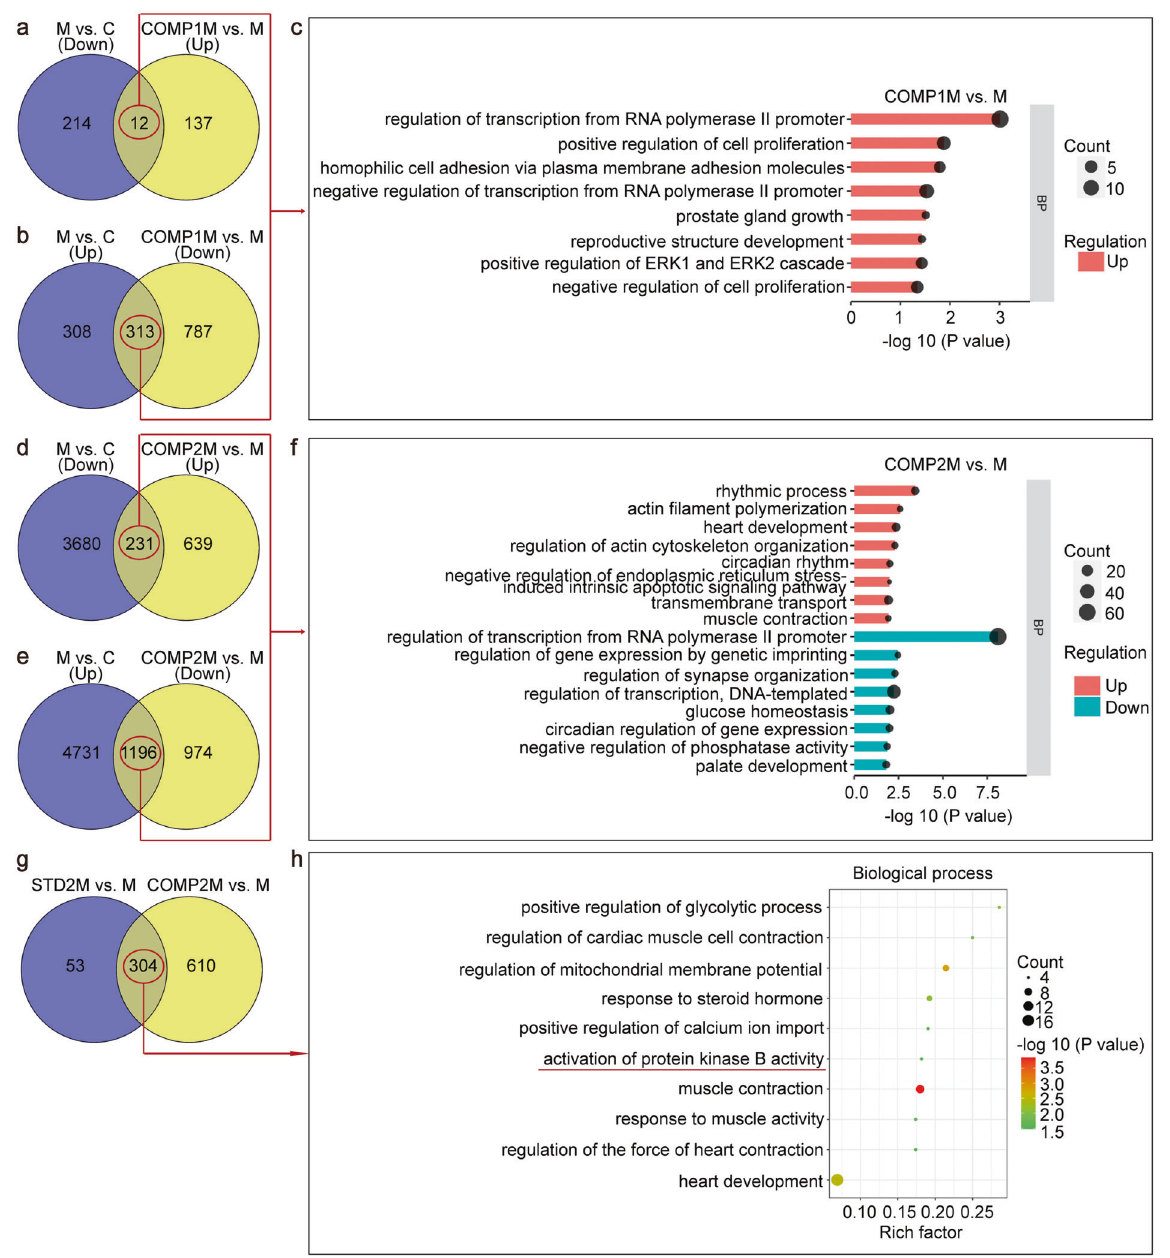
Fig. 6 Gene expression pro fi ling of the heart by RNA-seq after hiPS-CMs transplantation treatment. a Venn diagram showing that the upregulated differentially expressed genes (DEGs) of “ COMP1M vs. M ” group overlap with the downregulated DEGs of “ M vs. C ” group, for a total of 12 overlapping genes. b Venn diagram showing the intersection of upregulated DEGs in the “ M vs. C ” group and the downregulated DEGs in the “ COMP1M vs. M ” group, with a total of 313 intersecting genes. c Gene ontology (GO) enrichment analysis of the 12 and 313 DEGs obtained above. The biological pathways that were enriched among genes were ranked based on – log10( P -value). Enrichment was performed using the DAVID database. The eight of the most signi fi cantly enriched biological process GO terms were shown ( P < 0.05). d Venn diagram showing 231 overlapping genes between the downregulated DEGs of “ M vs. C ” and upregulated DEGs of “ COMP2M vs. M ” groups. e Venn diagram of upregulated DEGs of “ M vs. C ” group compared with downregulated DEGs of “ COMP2M vs. M ” group. A total of 1196 shared genes. f Enrichment of GO biological processes identi fi ed from 231 and 1196 shared DEGs, respectively. g Venn dia g ram showing “ STD2M vs. M ” and “ COMP2M vs. M ” shared DEGs, with a total of 304 shared DEGs in both groups. h The most differentially overrepresented biological processes in “ COMP2M vs. M ” compared with “ STD2M vs. M ” were displayed. Three mice per group. “ Count ” means that the enriched DEGs numbers in the pathway. “ RichFactor ” represents the number of DEGs relative to total number of genes in the pathway, with larger RichFactors indicating greater enrichment. COMP1M, one month after the saponin + compound induced hiPS-CMs transplantation treatment group; COMP2M, two months after the saponin + compound induced hiPS-CMs transplantation treatment group; STD2M, two months after the standard induced hiPS-CMs transplantation treatment group; M, heart failure model group; C, control group. COMP1M vs. M, DEGs in the saponin + compound induced hiPS-CMs transplantation group treated for 1 month compared with the model group; COMP2M vs. M, DEGs